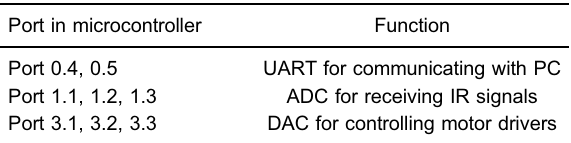
Table 1. Microcontroller port assignment. Port in microcontroller